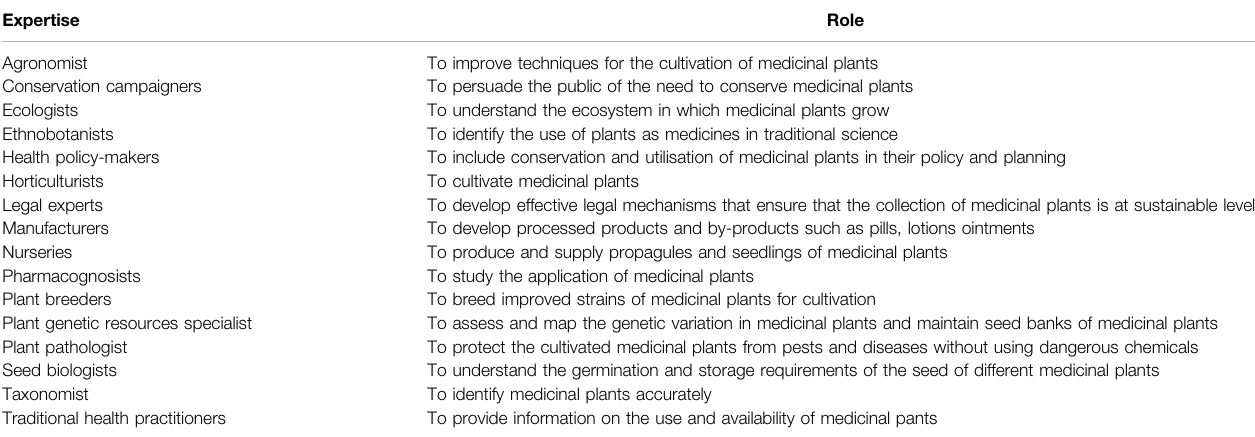
TABLE 2 | Identi fi ed key experts and their role in the commercialisation process of medicinal plants. Expertise